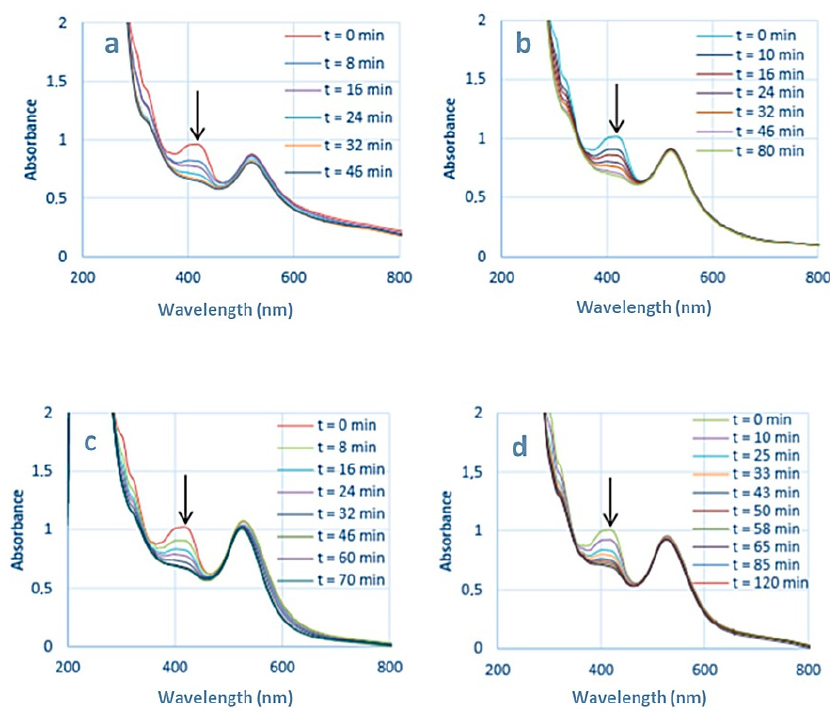
Figure 2. Temporal evolution of the UV-visible spectra of deaerated aqueous solutions containing 5 × 10 − 4 M sodium thiosulfate and 5 × 10 − 4 M potassium hexacyanoferrate: ( a ) in the presence of 15 nm Au-NPs@citrate under irradiation at λ = 520 nm; ( b ) in the presence of 15 nm Au-NPs@citrate in the dark; ( c ) in the presence of 30 nm Au-NPs@citrate under irradiation at λ = 520 nm, and ( d ) in the presence of 30 nm Au-NPs@citrate in the dark. Optical path length: 1 cm.